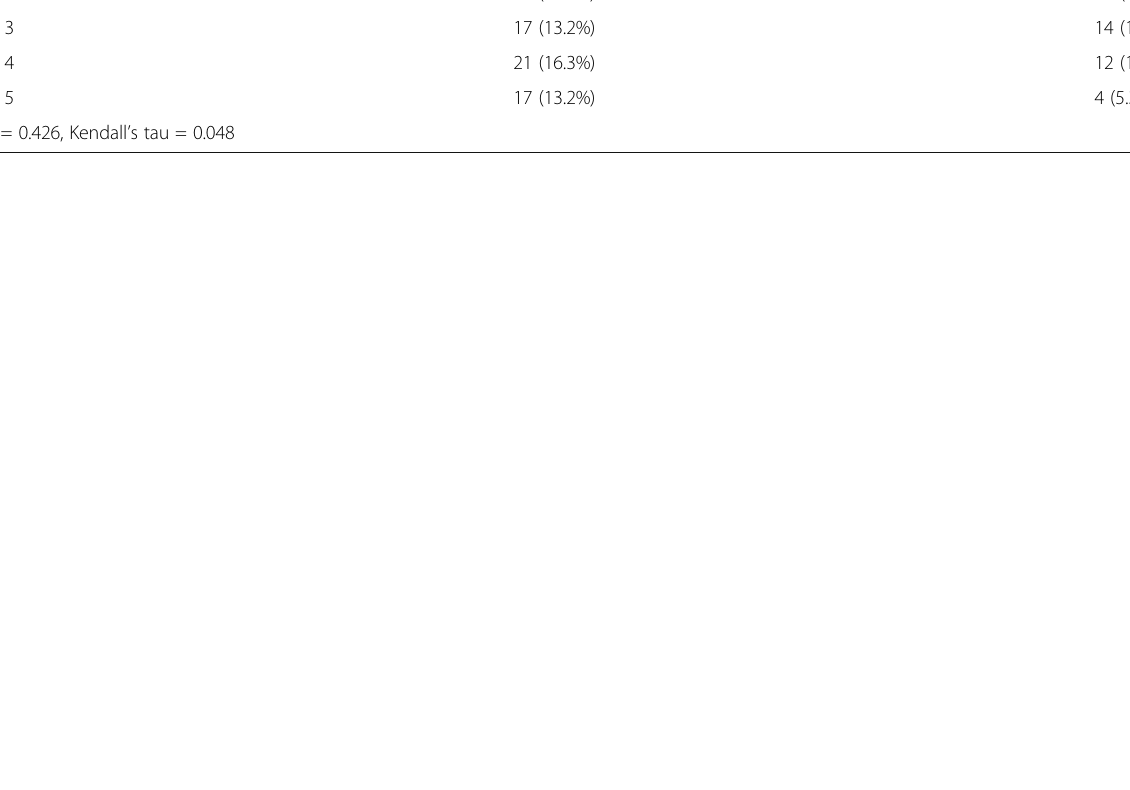
Table 8 Associations between age and concerns for driving and disapproval of friends and family ( n = 204) Age (years) Driving